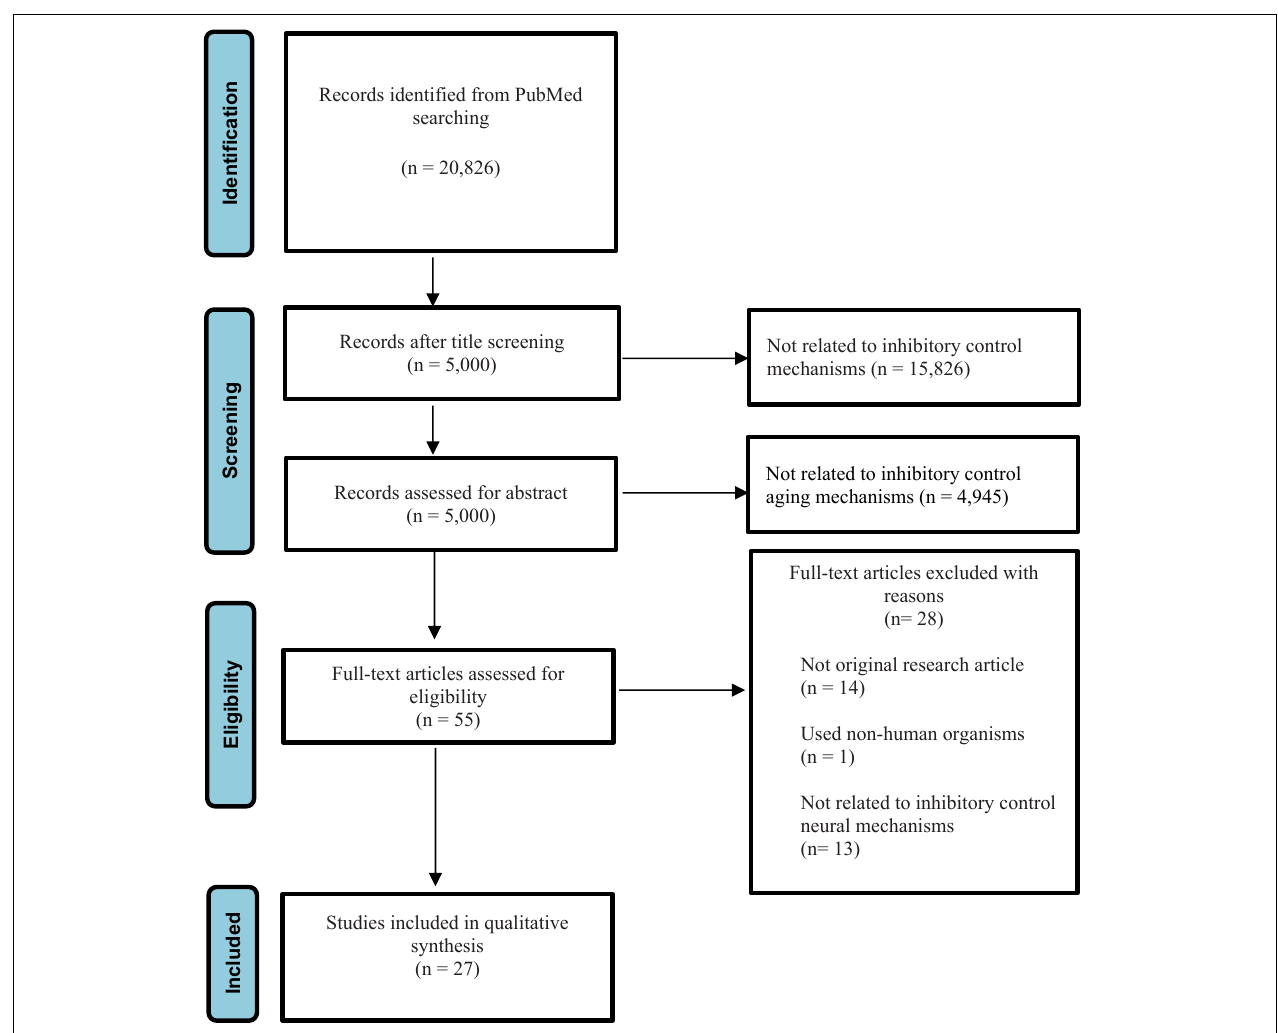
FIGURE 1 | The PRISMA chart that shows the process followed to select the included